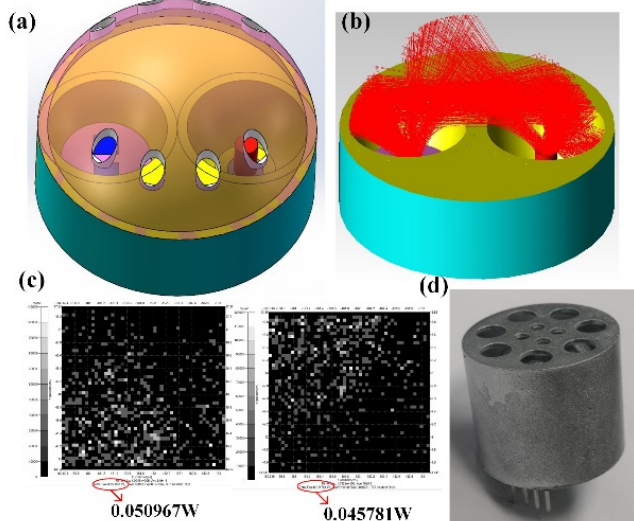
Figure 2. ( a ) 3D structure diagram of the optical chamber; ( b ) tracing simulation diagram of the absorbed rays; ( c ) comparison of luminous fluxes absorbed by two sensitive elements; ( d ) actual sample diagram of the gas sensor module.